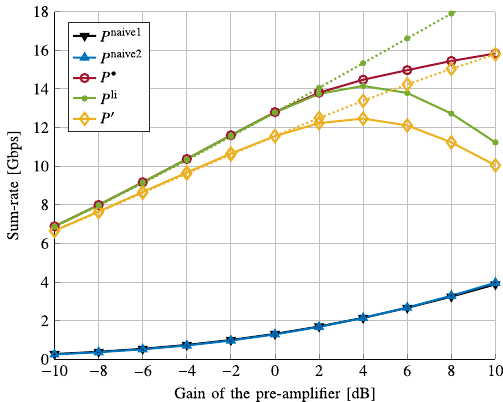
Fig. 4 Sum-rate vs. pre-amplifier gain G